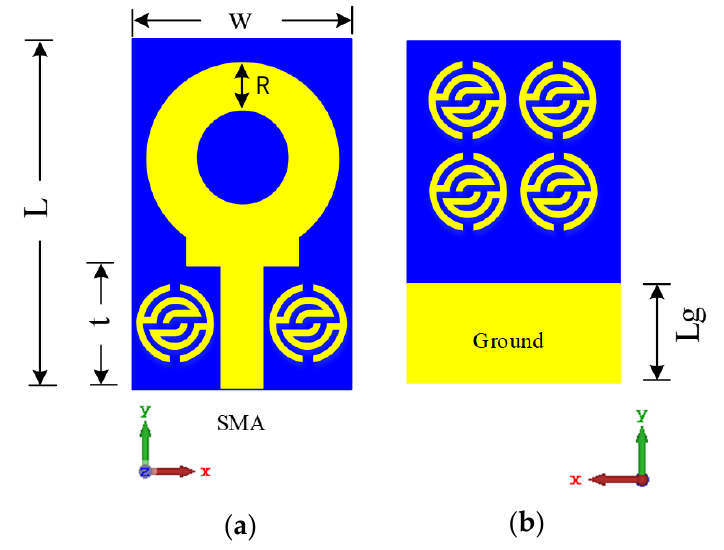
Figure 9. Geometry of the proposed antenna: ( a ) front view and ( b ) back view.